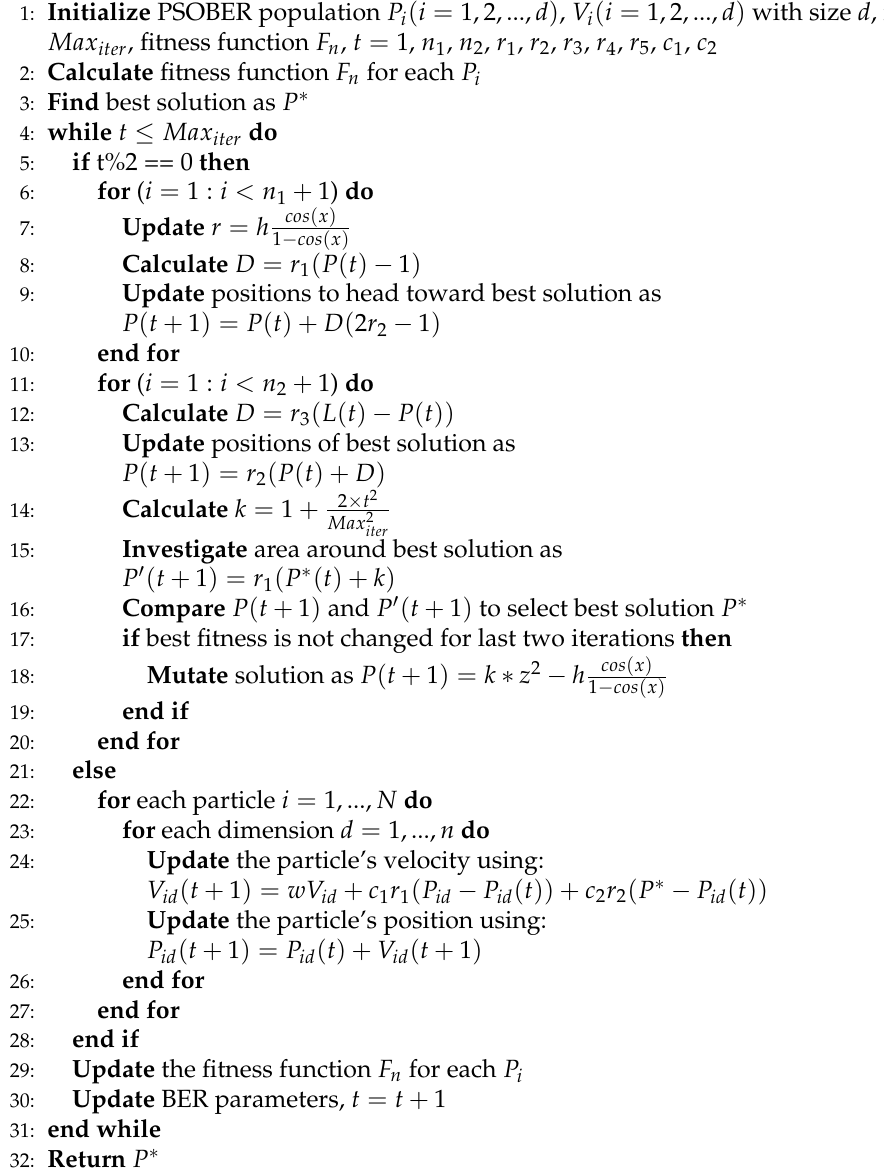
Algorithm 1 The PSOBER optimization